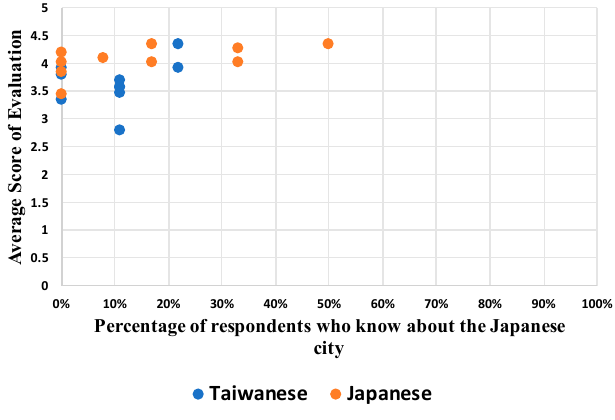
Figure 8. Evaluation result: Category 3.